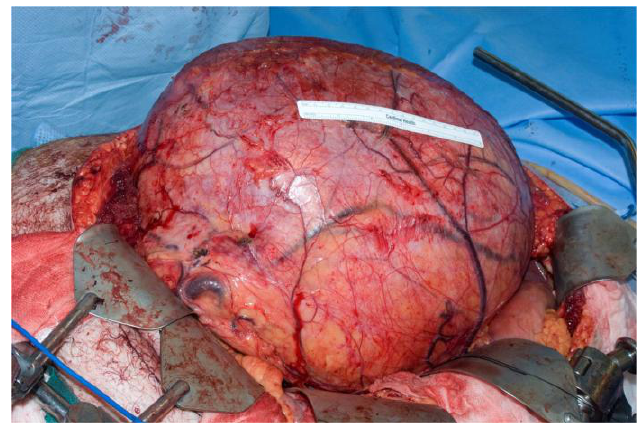
FIGURE 3. Intraoperative image during right nephrectomy.